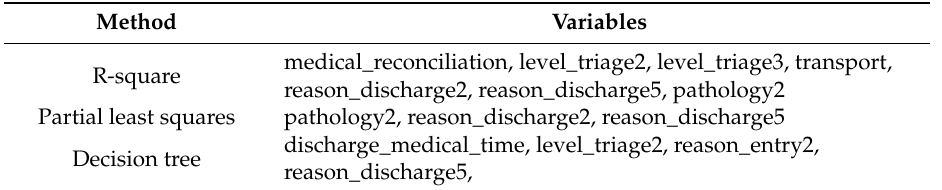
Table 8. Selection of missing data.